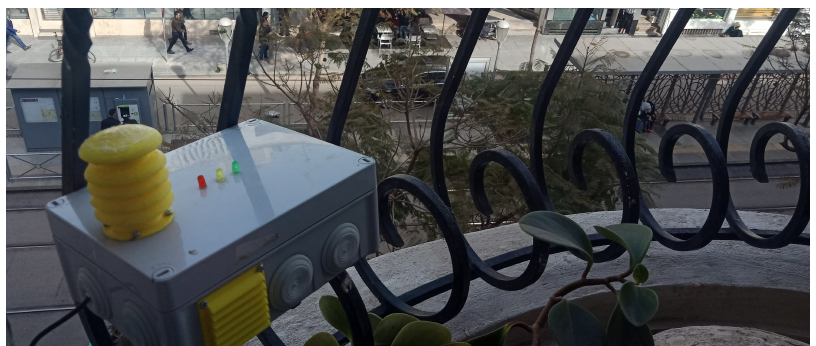
Figure 7. Nomadic sensor node